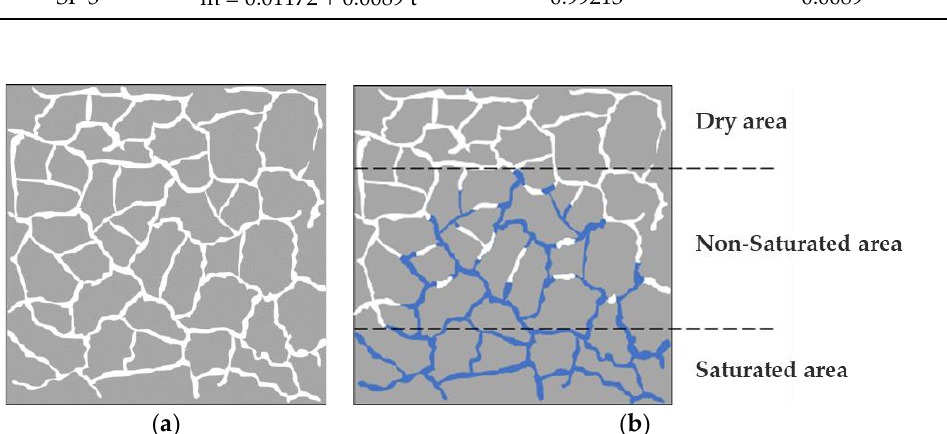
Figure 8. The capillary water distribution in the section of 1/2 length of the specimen (after 36 days of capillary water absorption).